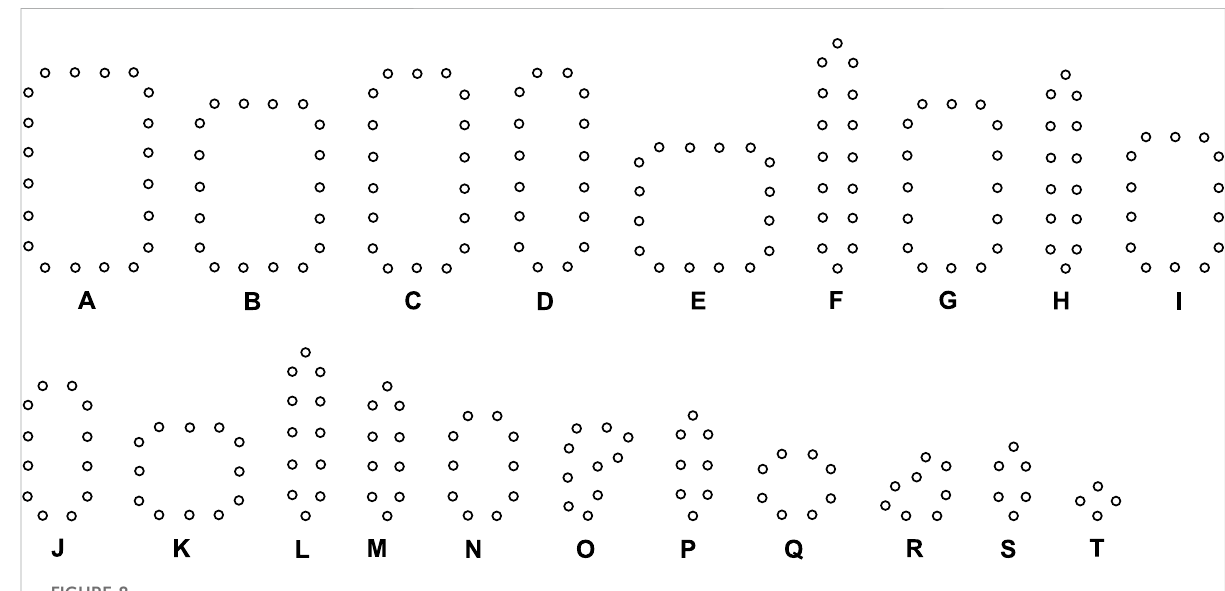
FIGURE 8 All fi nal loop structures starting from the con fi guration in Figure 7A by the greedy selection, adding, and changing mechanisms.